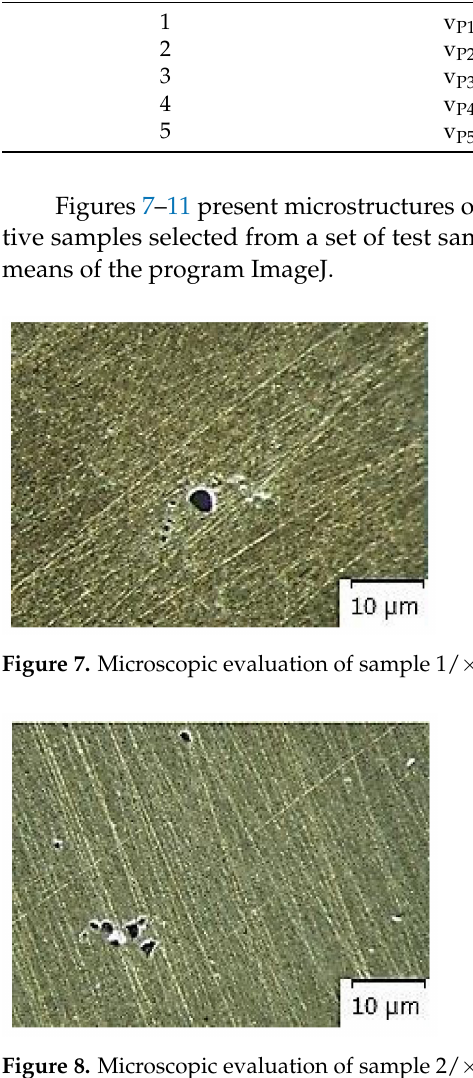
Table 5. Average porosity values of samples taken from the main runner. Sample No.